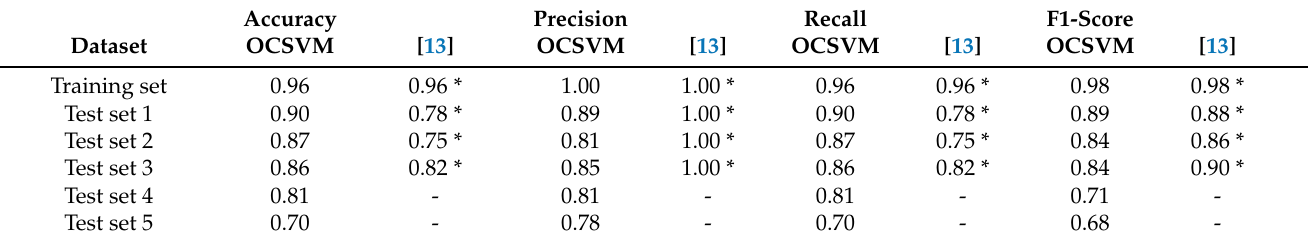
Table 5. Performance of OCSVM described here and the reported results * of the OCSVM in